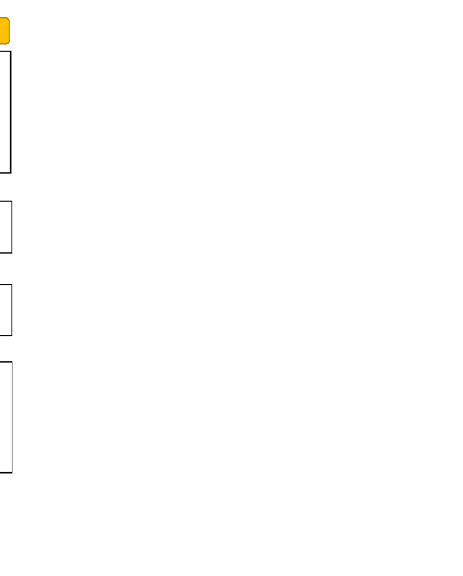
Fig 1. PRISMA flow diagram for systematic review and